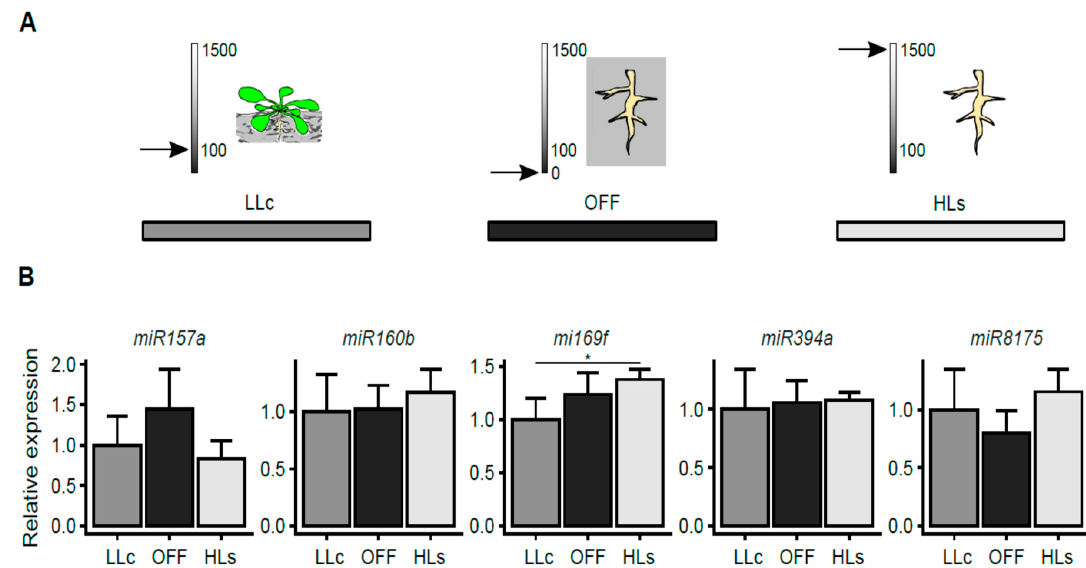
Figure 3. Verification of the stress signal source. ( A ) Experimental scheme: LLc: control roots (collected from plants grown in LL for 2 h); OFF: roots dissected from shoots as in LLc and kept in the dark for 2 h; HLs: roots dissected from shoots as in LLc and exposed to HL for 2 h. The arrows on the scales indicate light intensity ( µ mol photons m − 2 s − 1 ). ( B ) Expression level of miRNAs relative to two references, snoRNA85 and snoRNA101 . Error bars represent the standard deviation, and asterisks represent significant di ff erences at p -values < 0.05 (*). ANOVA and the HSD Tukey test were applied for statistical analysis. Results are from three independent experiments each pooled from six plants and three technical replicates.